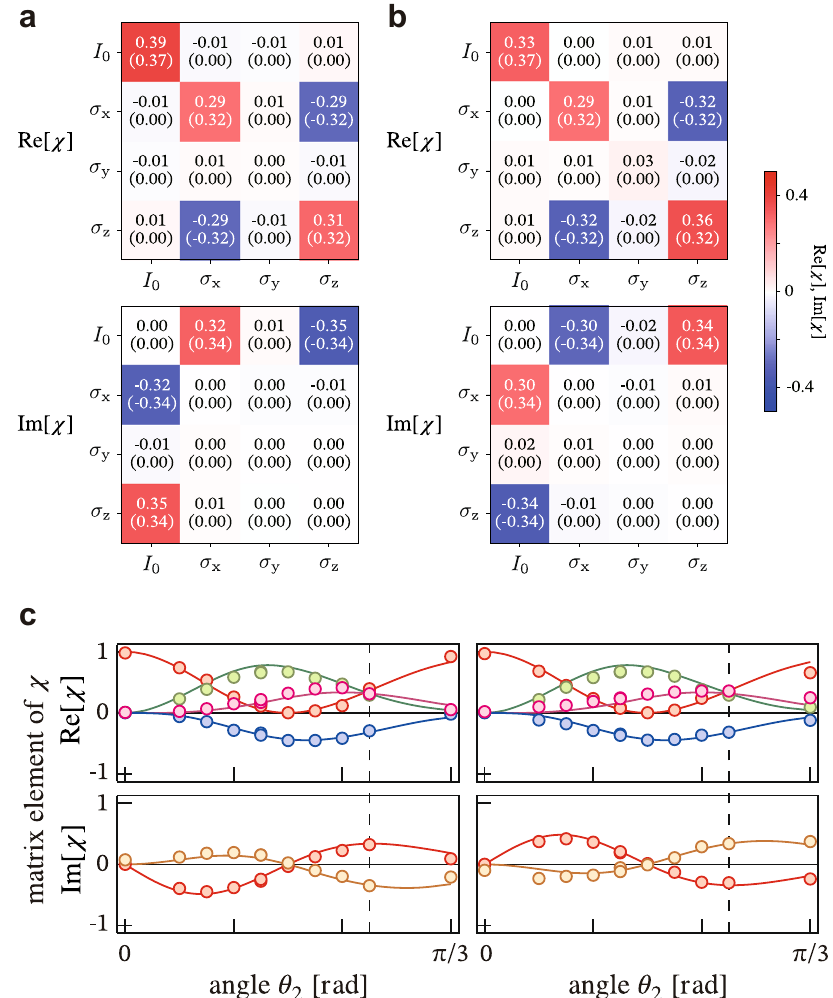
Fig. 3 Quantum process tomography. a , b Reconstructed process matrices χ ij of the non-Abelian holonomy ^ U C for a forward and b reversed ramps at θ 2 = π /4. The real part (Re[ χ ij ]) and the imaginary part (Im[ χ ij ]) are shown separately. Values in brackets are theoretical. The fi delity of the geometric process reached F C ¼ 0 : 98 and F C ¼ 0 : 96 for forward and reversed ramp, respectively. c Process matrix components ( χ ij ) for þ (cid:3) forward (left panels) and reverse (right panels) ramps for different W.-Z. phase realizations. The top panel shows the real parts [ χ 00 (red), χ χ χ χ χ is Hermitian. The χ xx (green), zz (purple), xz (blue)] and the bottom panels show the imaginary parts [ 0 x (red), 0 z (orange)]. We note that solid curves are the theory. Matrix components that are constantly zero in the theory are not shown for